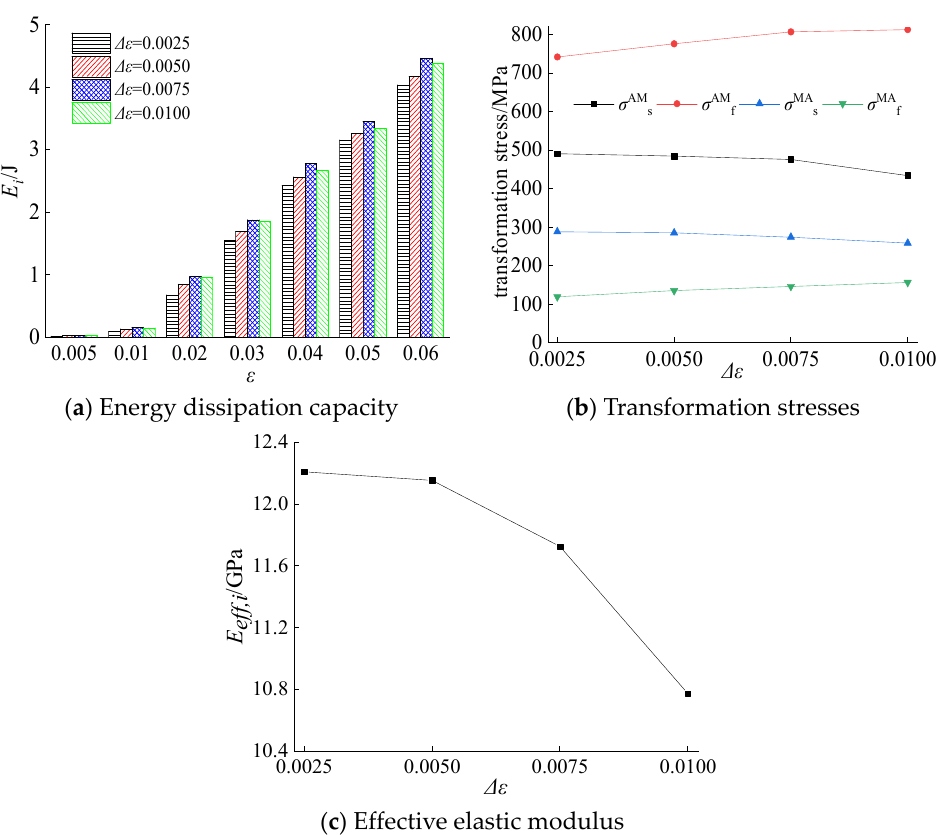
Figure 5. Effect of the initial strain on the hysteresis curve of the pre-tensioned SMA wire.